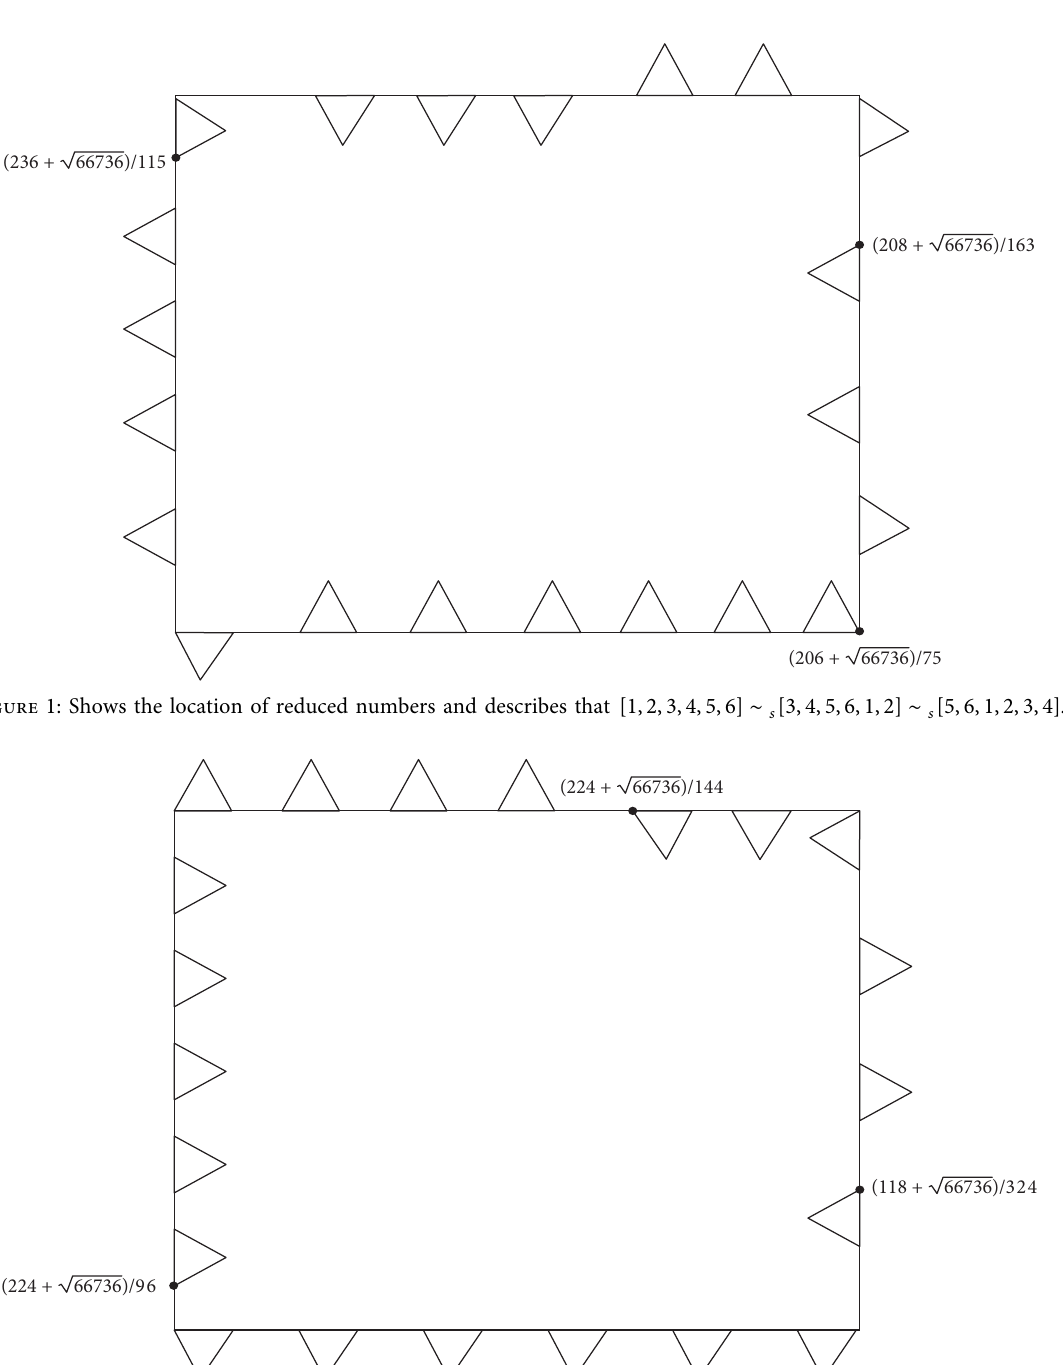
[ 4 , 5 , 6 , 1 , 2 , 3 ] ∼ [ 6 , 1 , 2 , 3 , 4 , 5 ] s s